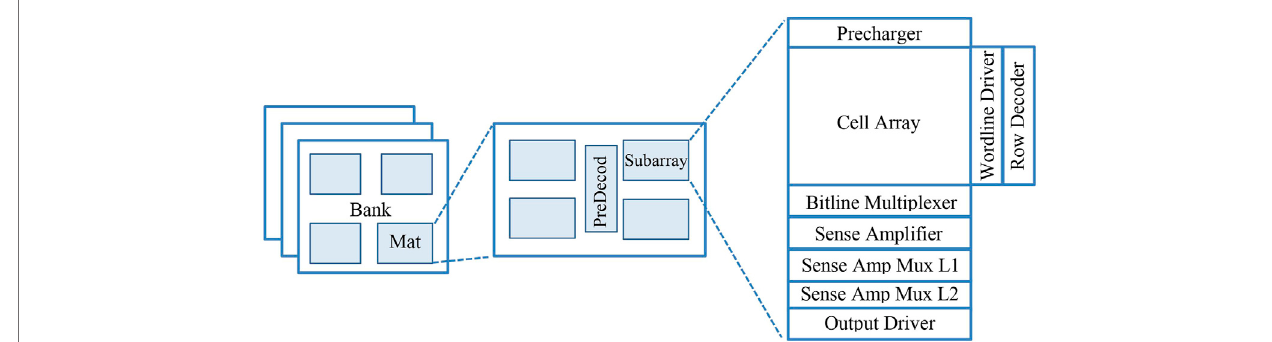
FIGURE 2 | Memory array organization in NVSim (Xiangyu Dong et al., 2012).